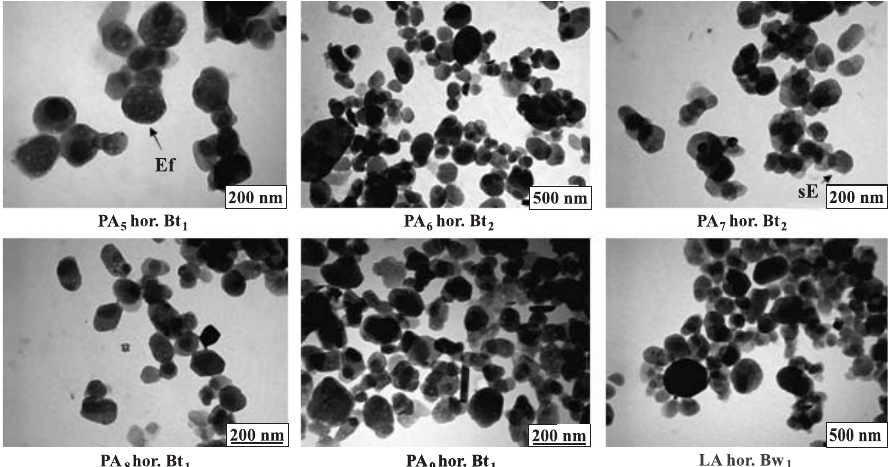
Figura 8. Micrografia de MET de amostras de caulinitas menores que 0,2 μ m desferrificadas dos solos estudados, ilustrando a ampla variação de morfologia: A: alongada; Eh: euedral hexagonal; sE: subesférica; Ef: esférica; I: indefinida. Escala em nanômetros.